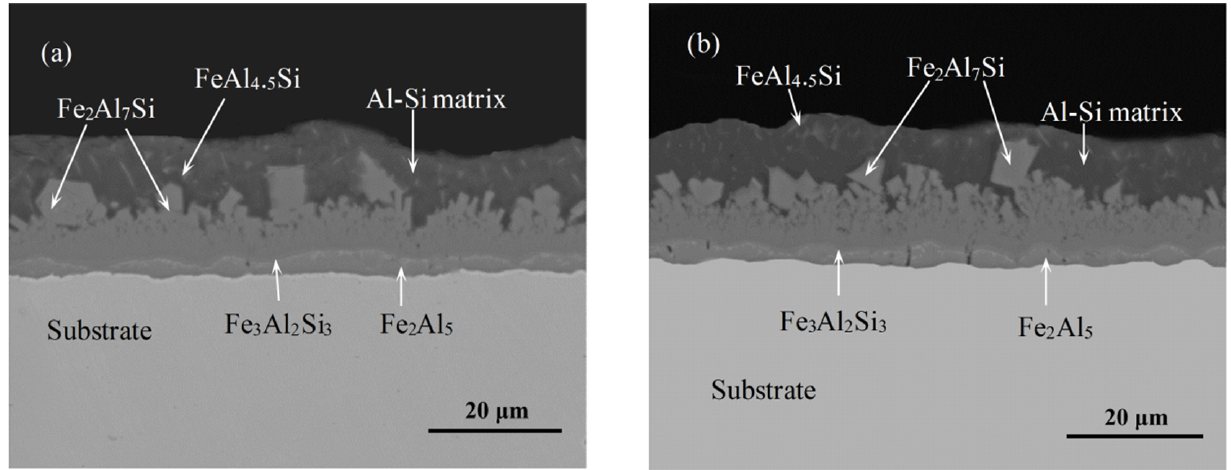
Figure 6. Influence of two-step heating methods on microstructure of Al–Si coating boron steel sheet of ( a ) Scheme A and ( b ) Scheme B.